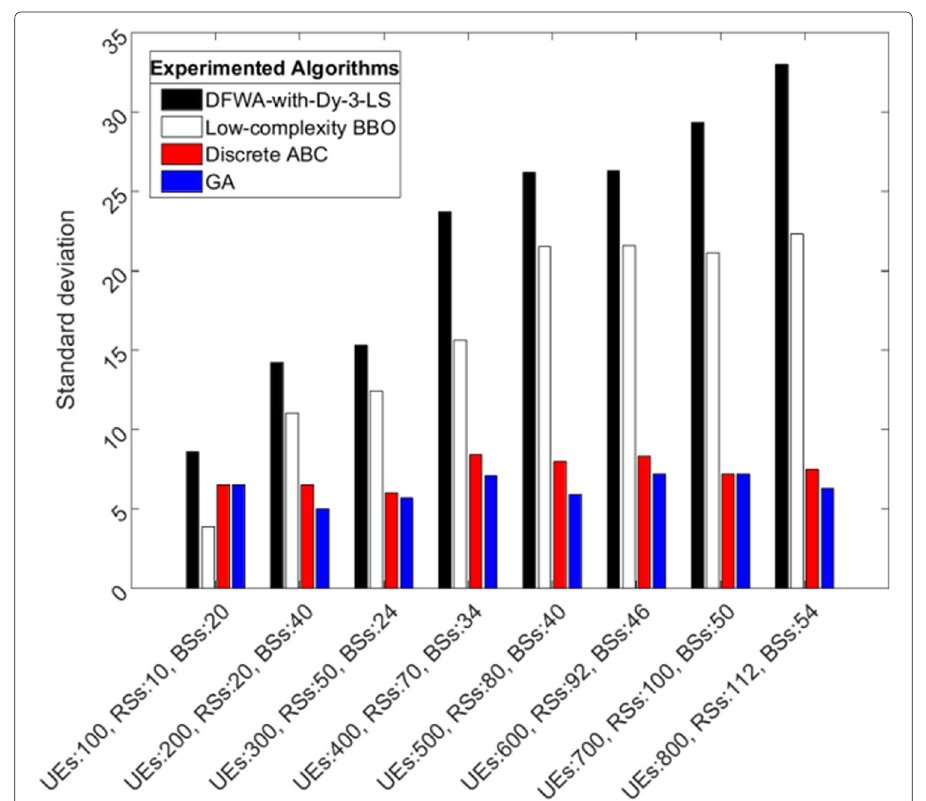
Fig. 4 Standard deviation (Std.) for the experimented